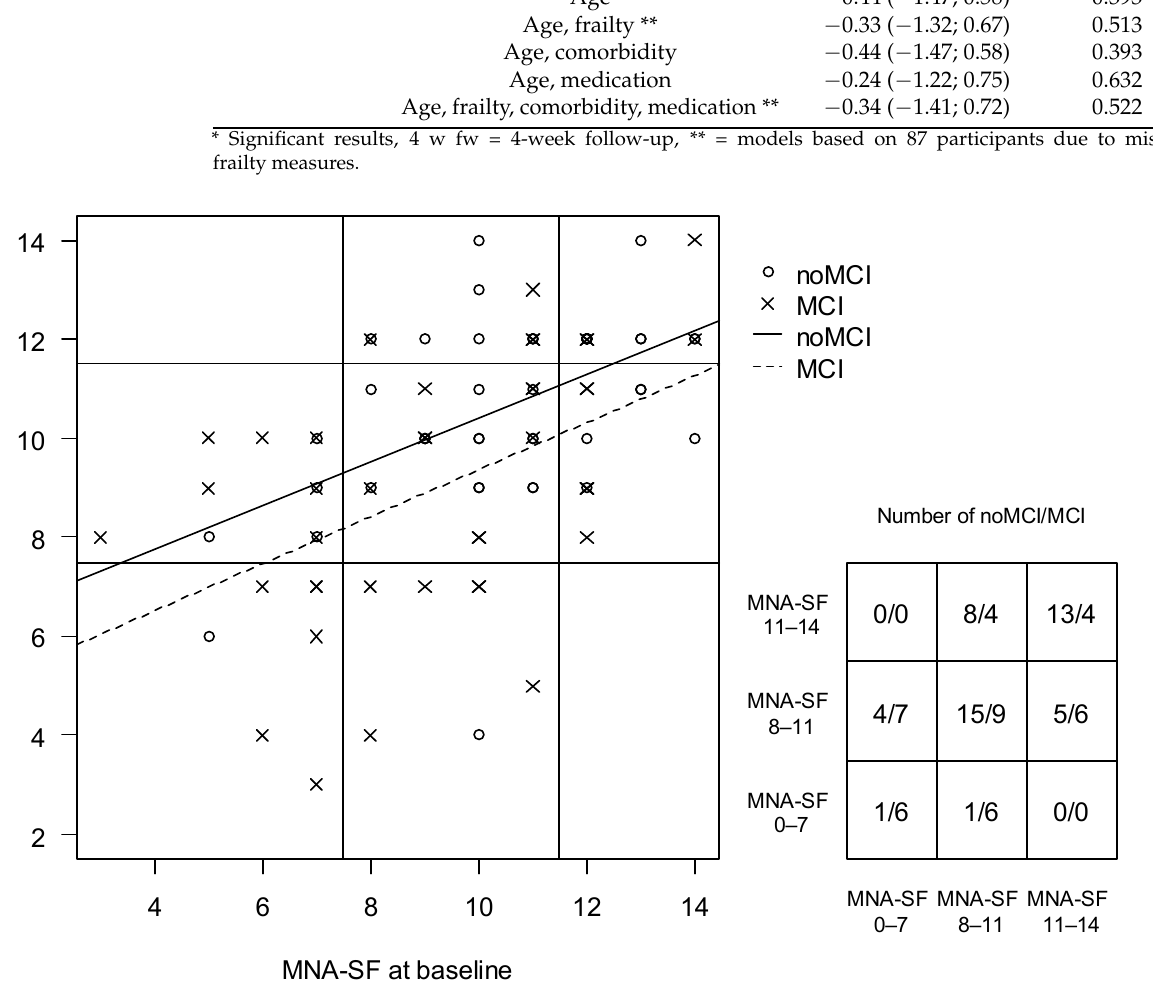
Figure 3. Nutritional status (MNA-SF score) at baseline and 4-week follow-up for participants with mild cognitive impairment (MCI) and participants with intact cognition (noMCI) with observation- matrix (MCI/noMCI), n = 89. MCI = Mild Cognitive Impairment; noMCI = Intact cognition, MNA-SF = Mini Nutritional Assessment—Short Form, MNA-SF score 0–7 = Malnutrition; MNA-SF score of 8–11 = risk of malnutrition; MNA-SF score 12–14 = normal nutritional status